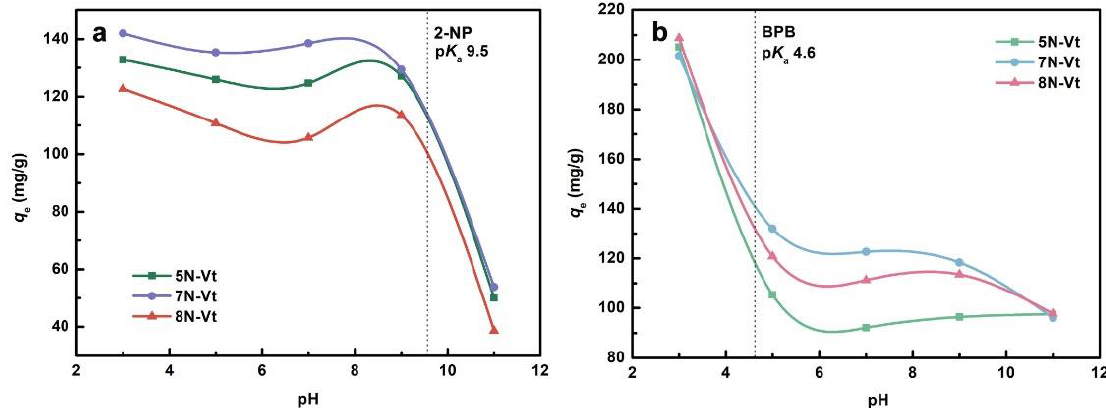
Figure 7. The effects of solution pH on the adsorption of 2-NP ( a ) and BPB ( b ).